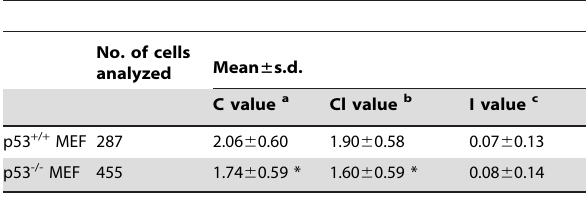
Table 2. Centrosome behavior of MEF cells with extra